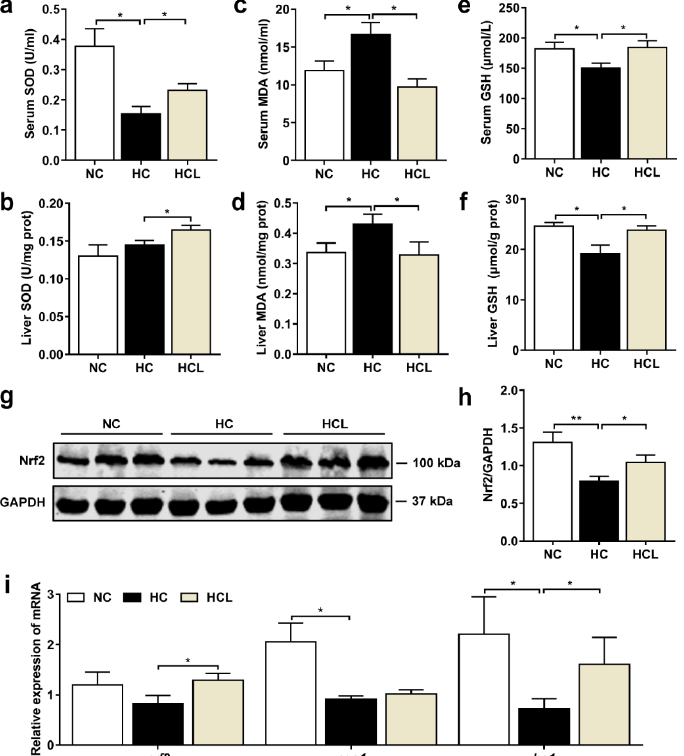
Figure 2. L. plantarum MR1 relieved the HC-induced oxidative stress in Nile tilapia. ( a , b ) The activities of superoxide dismutase (SOD) in the serum ( a ) and liver ( b ) ( n = 6). ( c , d ) The contents of malondialdehyde (MDA) in the serum ( c ) and liver ( d ) ( n = 6). ( e , f ) The contents of reduced glutathione (GSH) in the serum ( e ) and liver ( f ) ( n = 6). ( g , h ) The protein expression and quantification of Nrf2 in the liver ( n = 6). ( i ) The relative mRNA expression of genes for Nrf2 signaling pathway in the liver ( n = 6). Statistics were analyzed by one-way ANOVA with Tukey’s adjustment and presented as mean ± SEM (*, p < 0.05; **, p < 0.01).